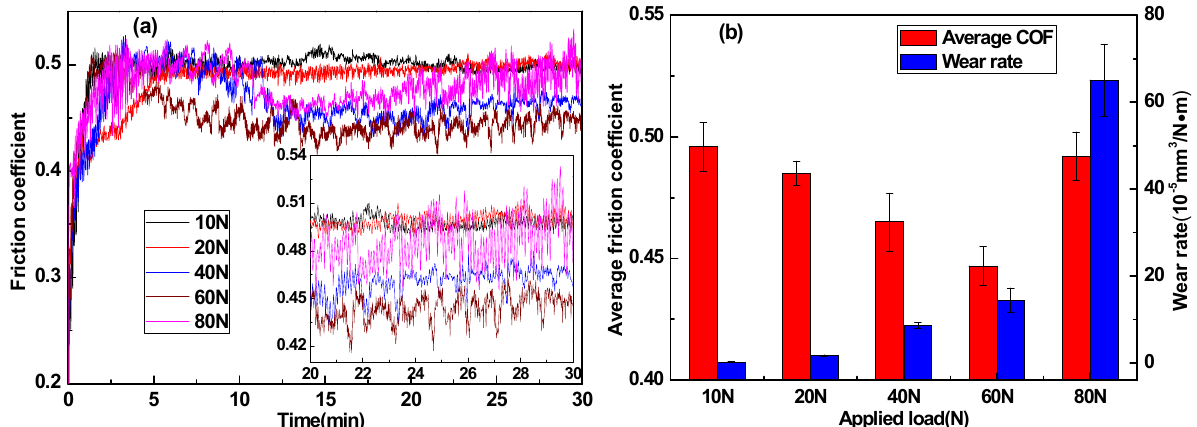
Figure 7. Development of friction coefficient over testing time for S4 ( a ), and average COF and wear rate for S4 at different applied loads ( b ).